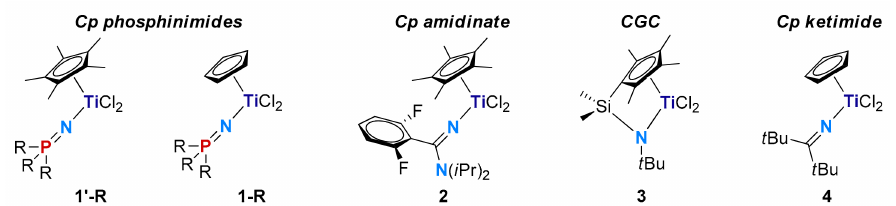
Figure 1. Representative Ti-based ‘post-metallocenes’. R = alkyl or